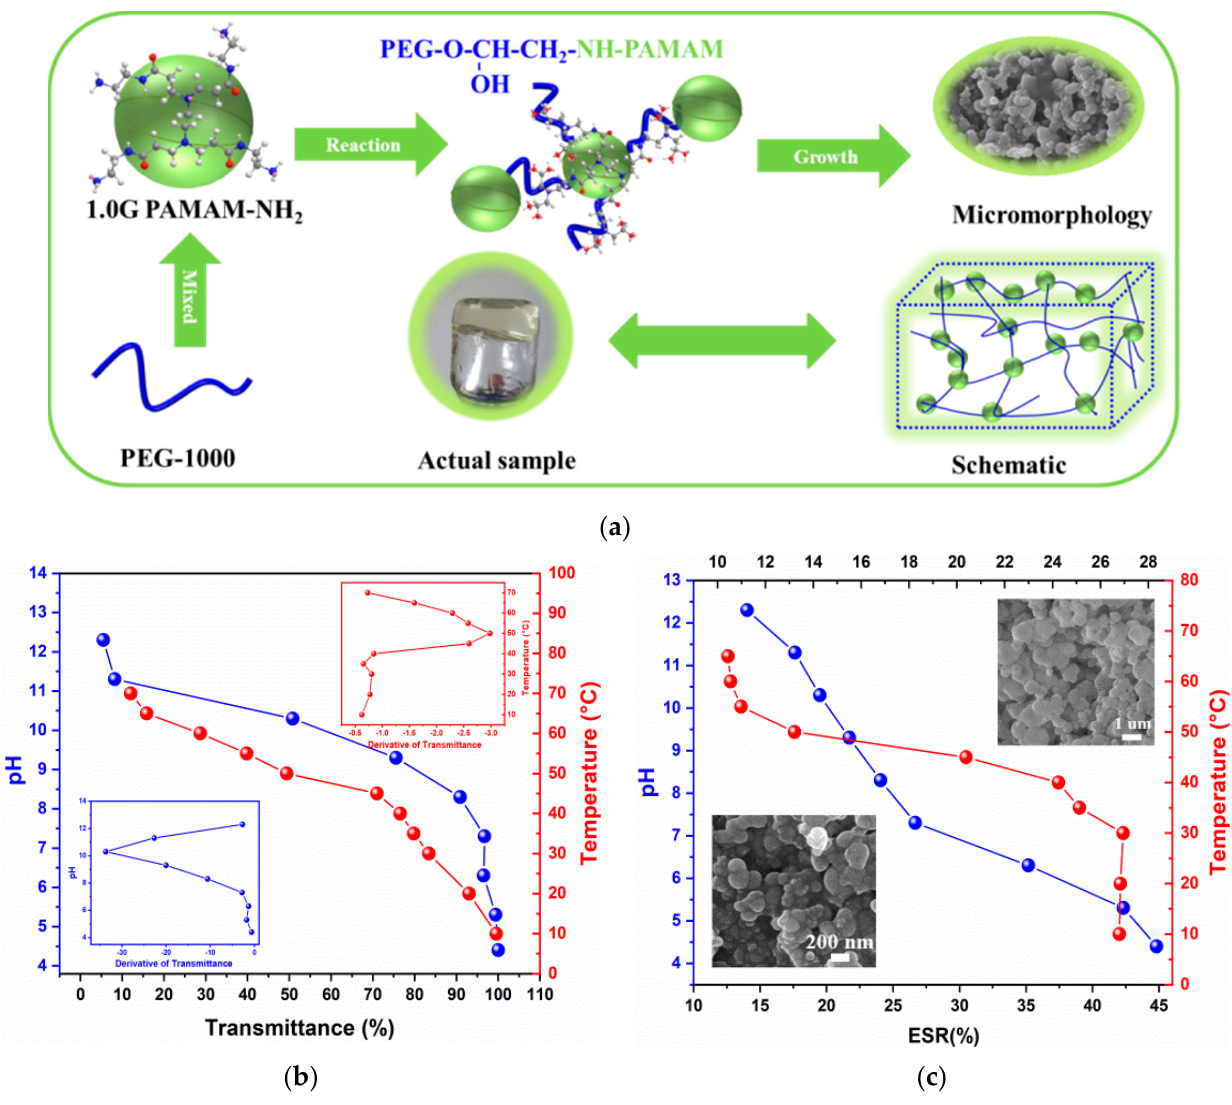
Figure 1. ( a ) Schematic diagram of PEG/PAMAM hydrogel gelation. ( b ) Transmittance and phase transition temperature and pH curves of PEG/PAMAM hydrogels. ( c ) Equilibrium swelling ratio curves of PEG/PAMAM hydrogels under different temperatures and pHs.